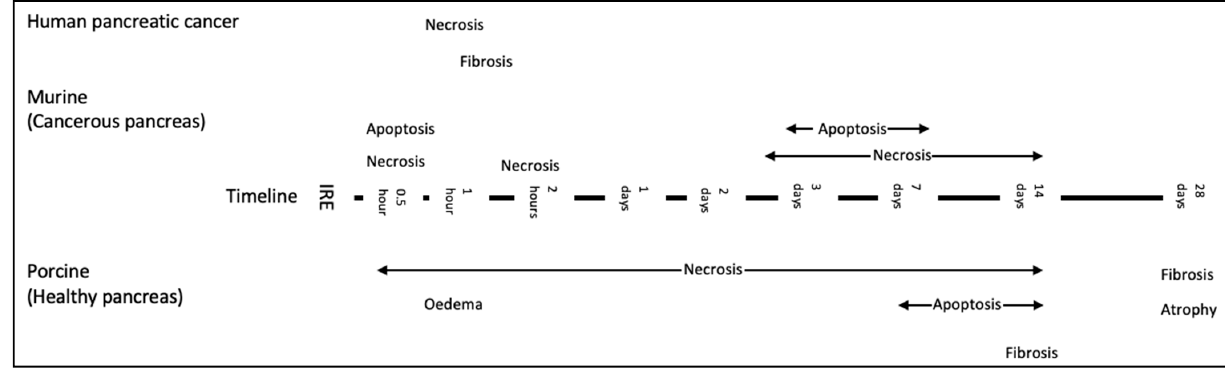
Figure 3. Timeline of the histological changes following pancreas IRE reported in the literature across all models [23,24,100–102,109]. Histological data from studies assessing new methods of delivery have not been included in this diagram and are considered separately, please see below.